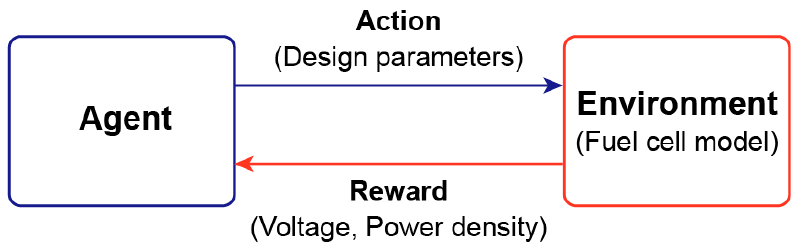
Figure 4. Schematic diagram of multi-armed bandit algorithm (MAB).